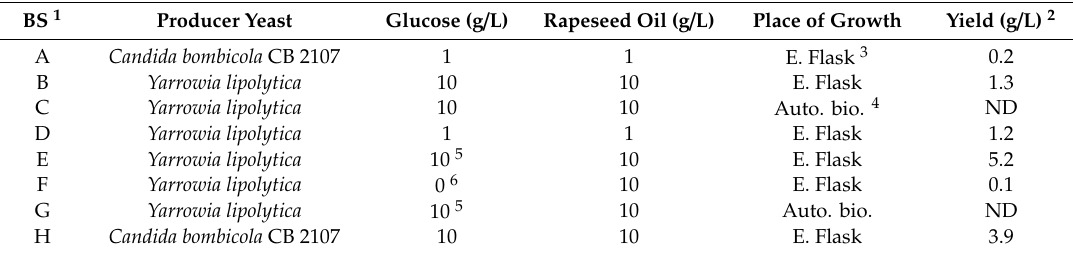
Table 1. Substrates involved in the production of the sophorolipids.